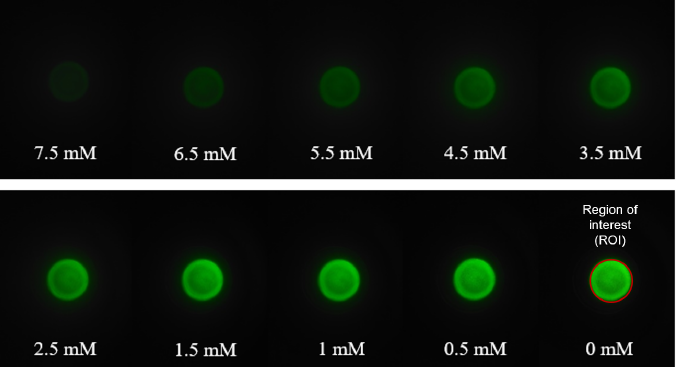
Figure 4. Images of blood plasma samples at different [K + ], in the presence of Na-TPB.